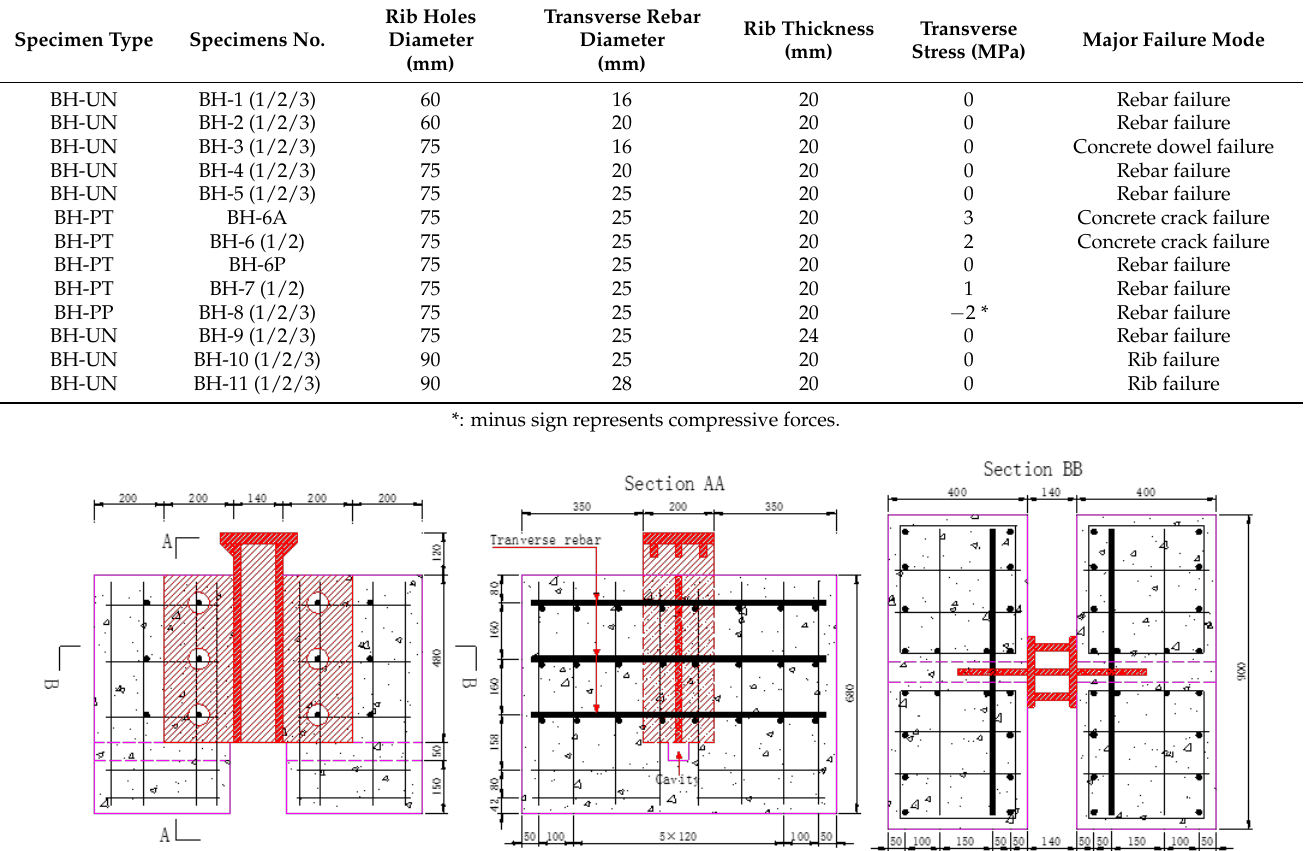
Table 1. Specimen dimensions and transverse forces.